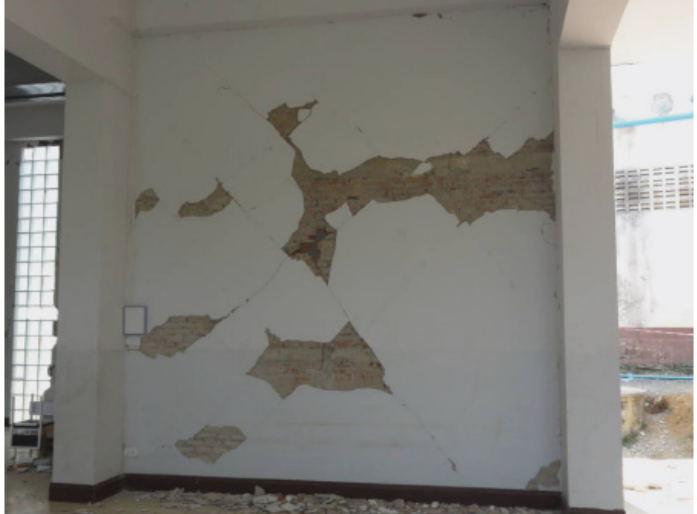
Figure 2. Diagonal cracks in a masonry wall [7].